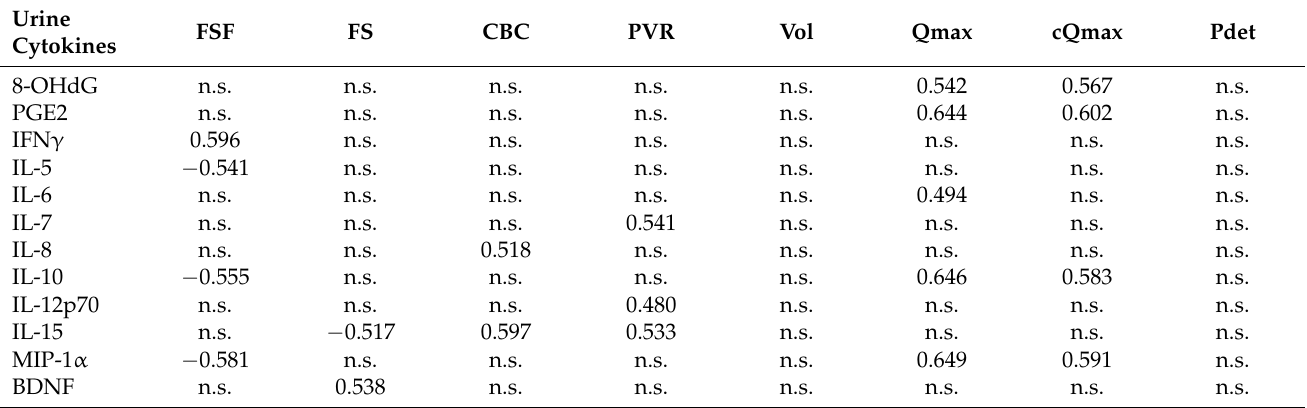
Table 5. The correlation coefficient (r value) between urine biomarker levels and VUDS parameters in patients with